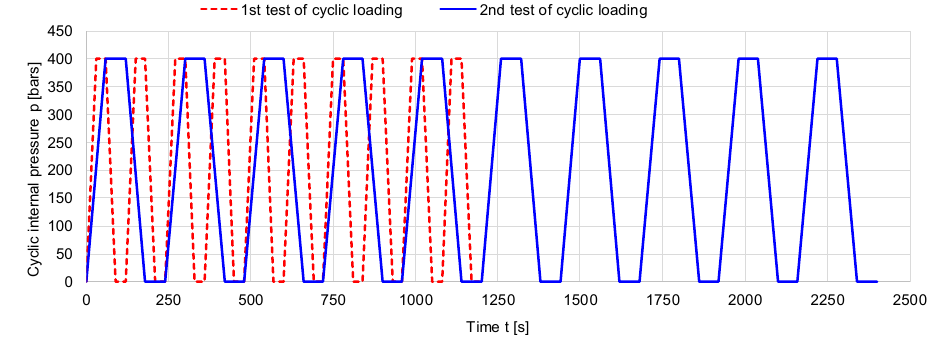
Table 2. Geometrical characteristics of samples tested to cyclic internal pressure.